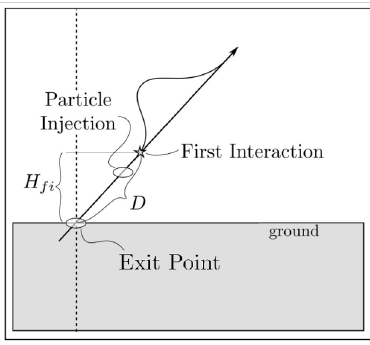
Figure 4. Parameters used in the simulation of UG EASs. Height of the first interaction H fi , and the distance between the particle exit point from the ground and the first interaction D are shown.